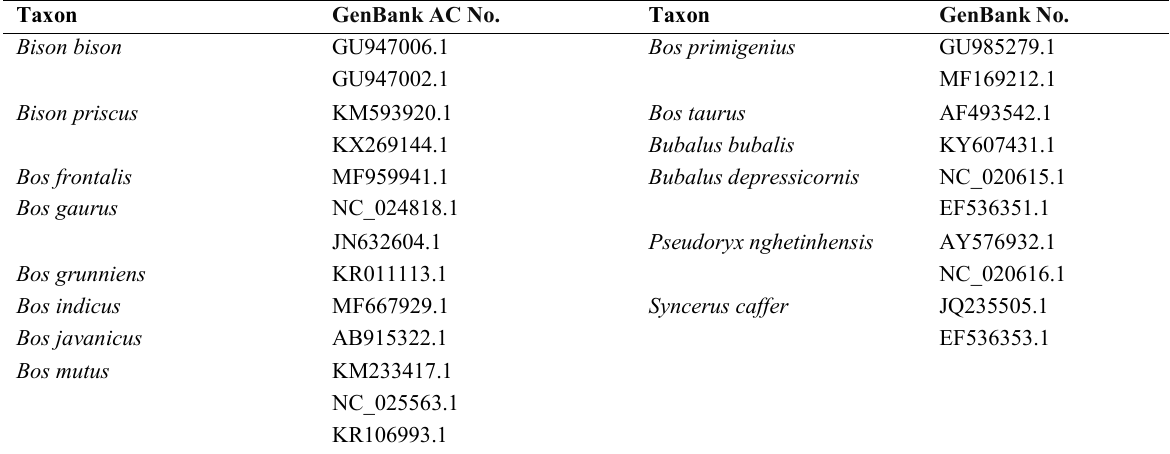
Table 5. The list of NADH dehydrogenase subunit I ( ND1 ) gene samples (in alphabetical order) with GenBank accession number (n=23)